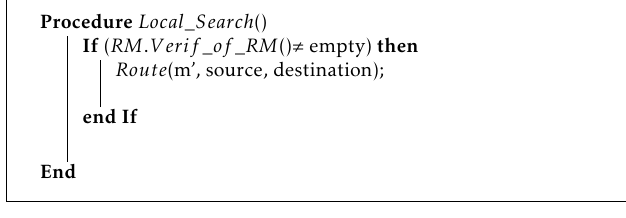
Algorithm 3: Local Search